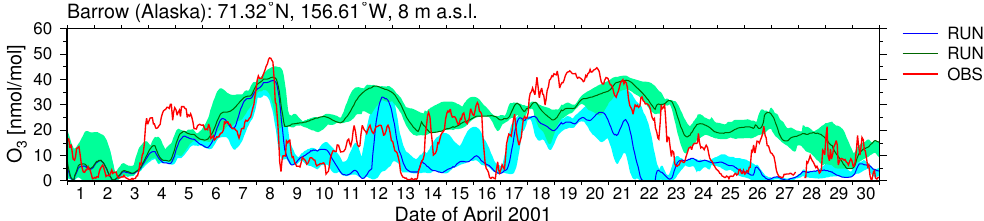
Fig. 5. The same as Fig. 3b but for simulated surface ozone mixing ratios at the nearest and surrounding grid cells to Barrow from Run 3 (blue line and shading) and Run 5 (green line and shading).